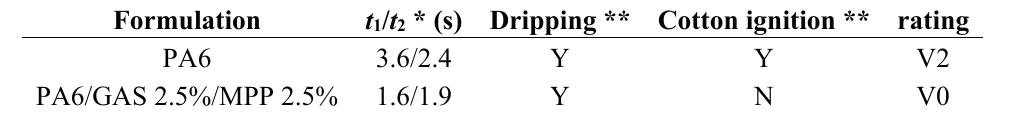
Table 5. UL 94 results for neat PA6 and for PA6/GAS 2.5%/MPP 2.5% extruded at a large